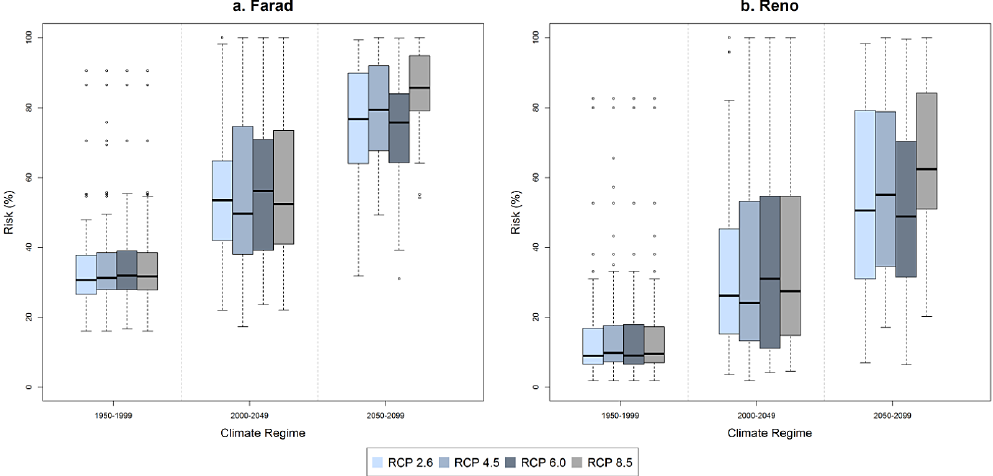
Figure 7. Box plots of the probability of a 1-day flood exceeding 1065cms (risk) in 10 years for three 50-year periods. Results are grouped by the representative concentration pathways (RCPs) used to drive the GCM projection. RCP 8.5 has the largest increase in greenhouse gas concentrations and RCP 2.6 the smallest.